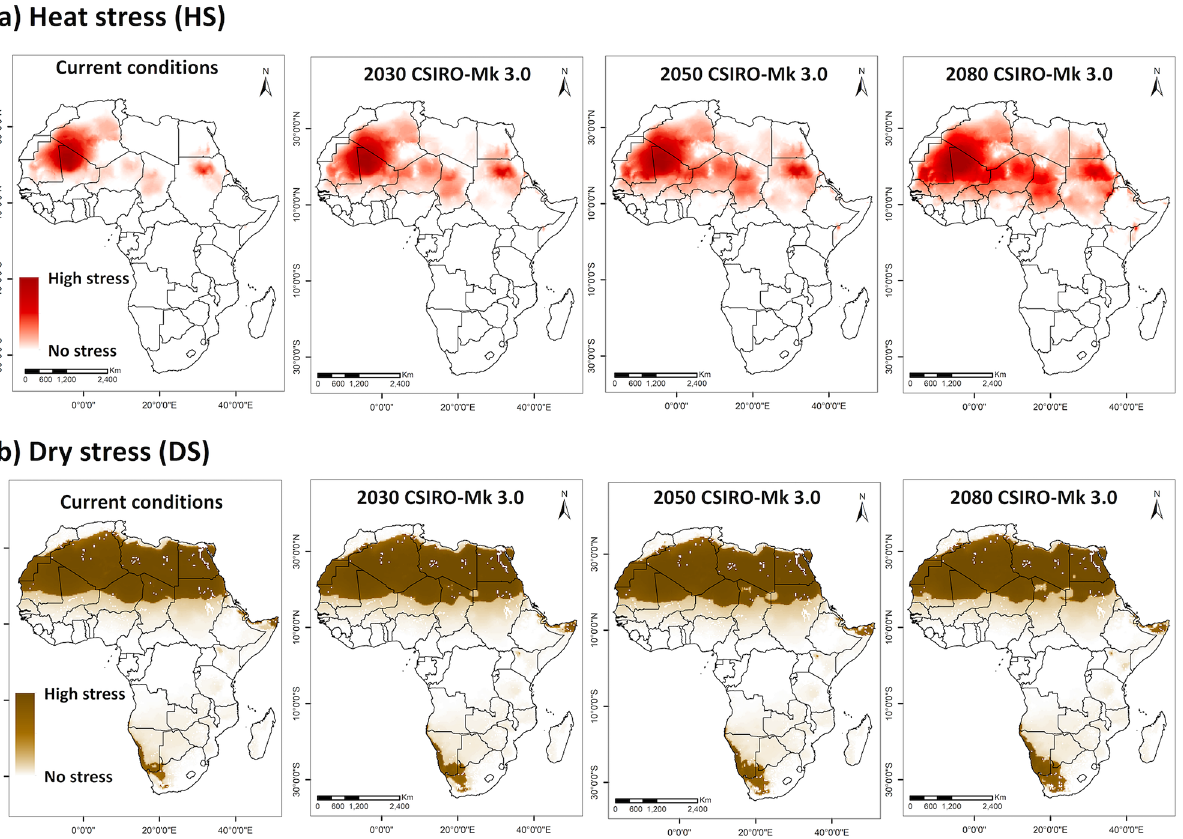
Figure 5. Abiotic stresses that limit FAW distribution and year-round establishment in Africa. Projected annual ( a ) heat stress and ( b ) dry stress for FAW under current and projected future climates (2030, 2050 and 2080) using CIRSO-Mk3.0 GCM, considering irrigation scenario II. ArcMap 10.8 (https:// deskt op. arcgis. com/ en/